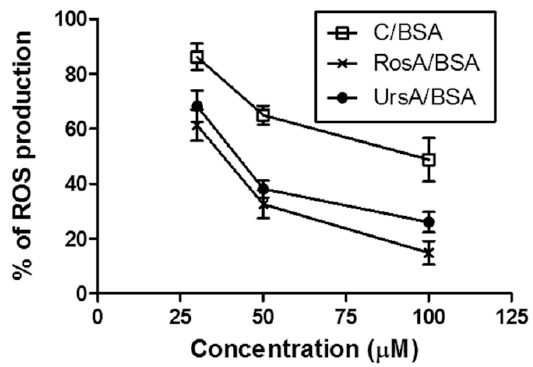
Figure 7. Results of the reactive oxygen species (ROS) production assay in the adult retinal pigmented epithelial (ARPE) cells. ROS production percentages were calculated by normalizing the fluorescent signals of treatment group cells (treated with 30–100 µ M C / BSA, RosA / BSA, or UrsA / BSA) by the signals of control group cells (without